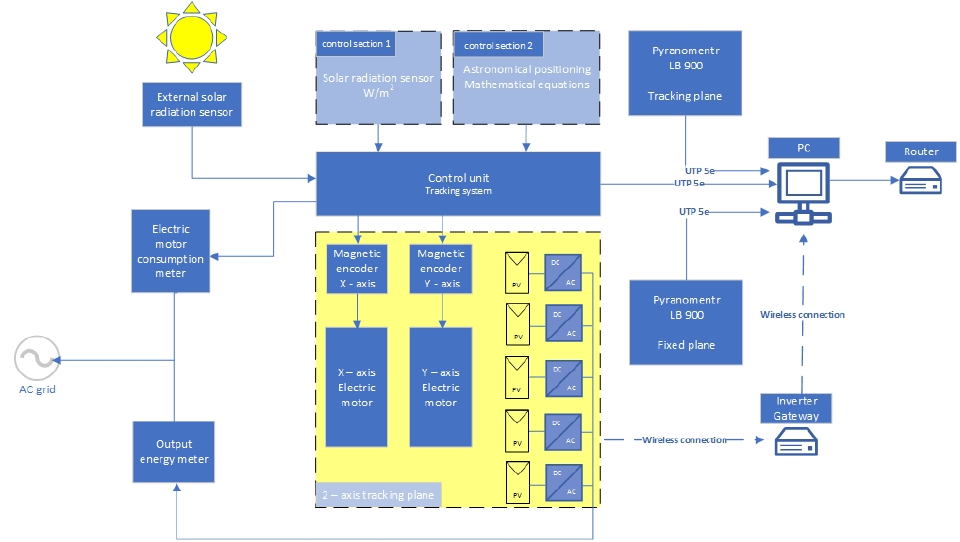
Figure 7. A schematic diagram of the MPPT control